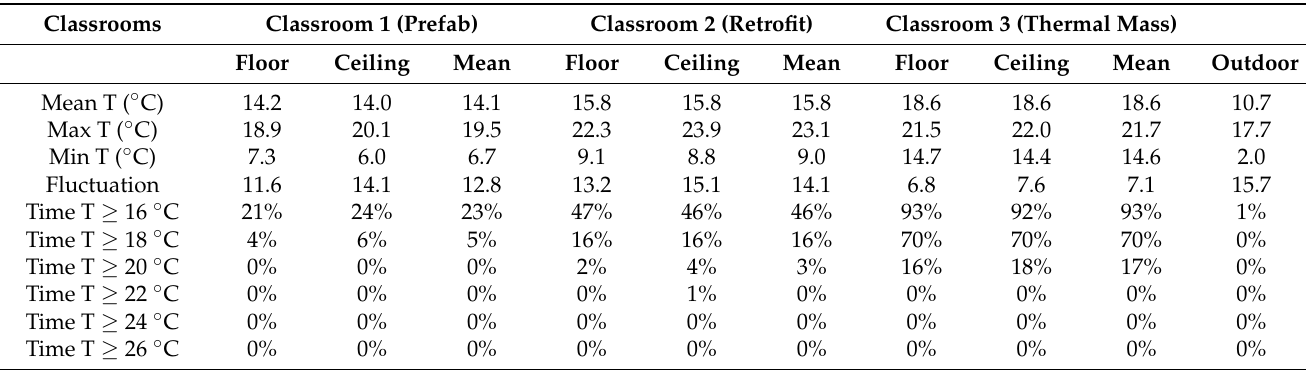
Table 4. Indoor temperatures and percentages of time related to different temperature ranges during winter nights (from 7 p.m. to 7 a.m.).